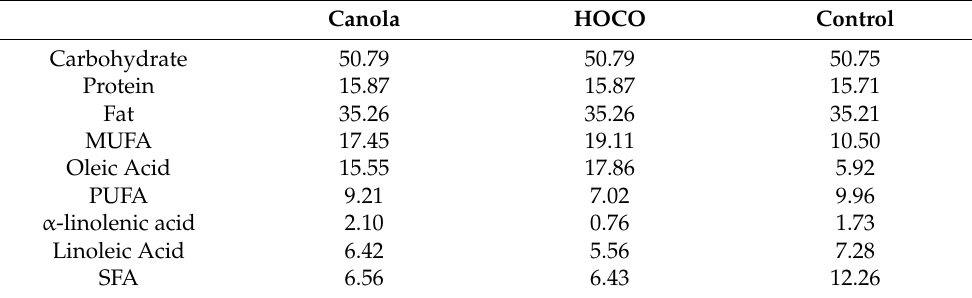
Table 1. Macronutrient composition of the three experimental diets, including oils 1,2